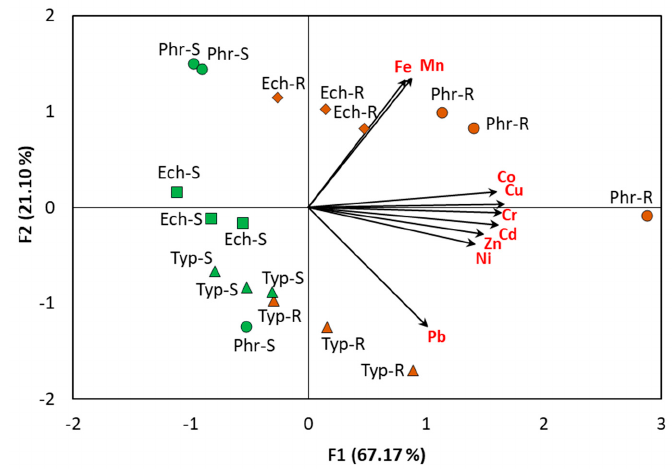
Figure 5. Principal component analysis of the heavy metals in the roots (R) and shoots (S) of Echinochloa stagnina (Ech), Phragmites australis (Phr) and Typha domingensis (Typ) based on the concentration of